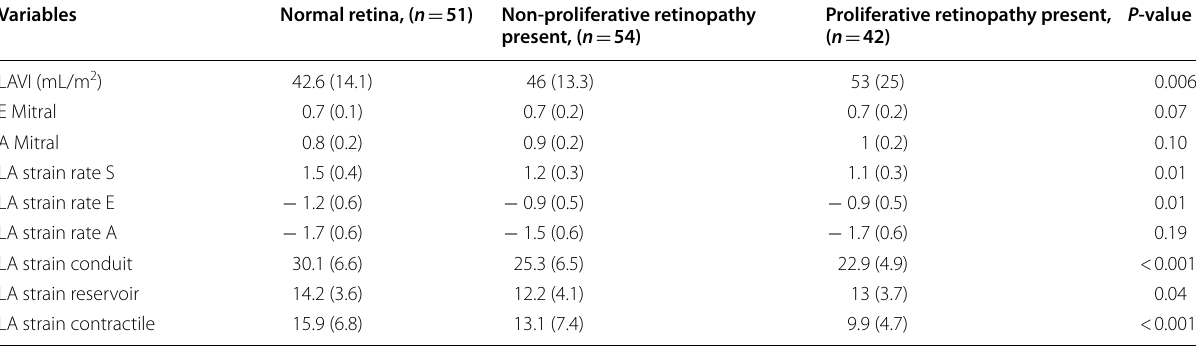
Table 3 Comparison of advanced echocardiographic parameters in diabetics with normal retina versus non-proliferative and proliferative retinopathy